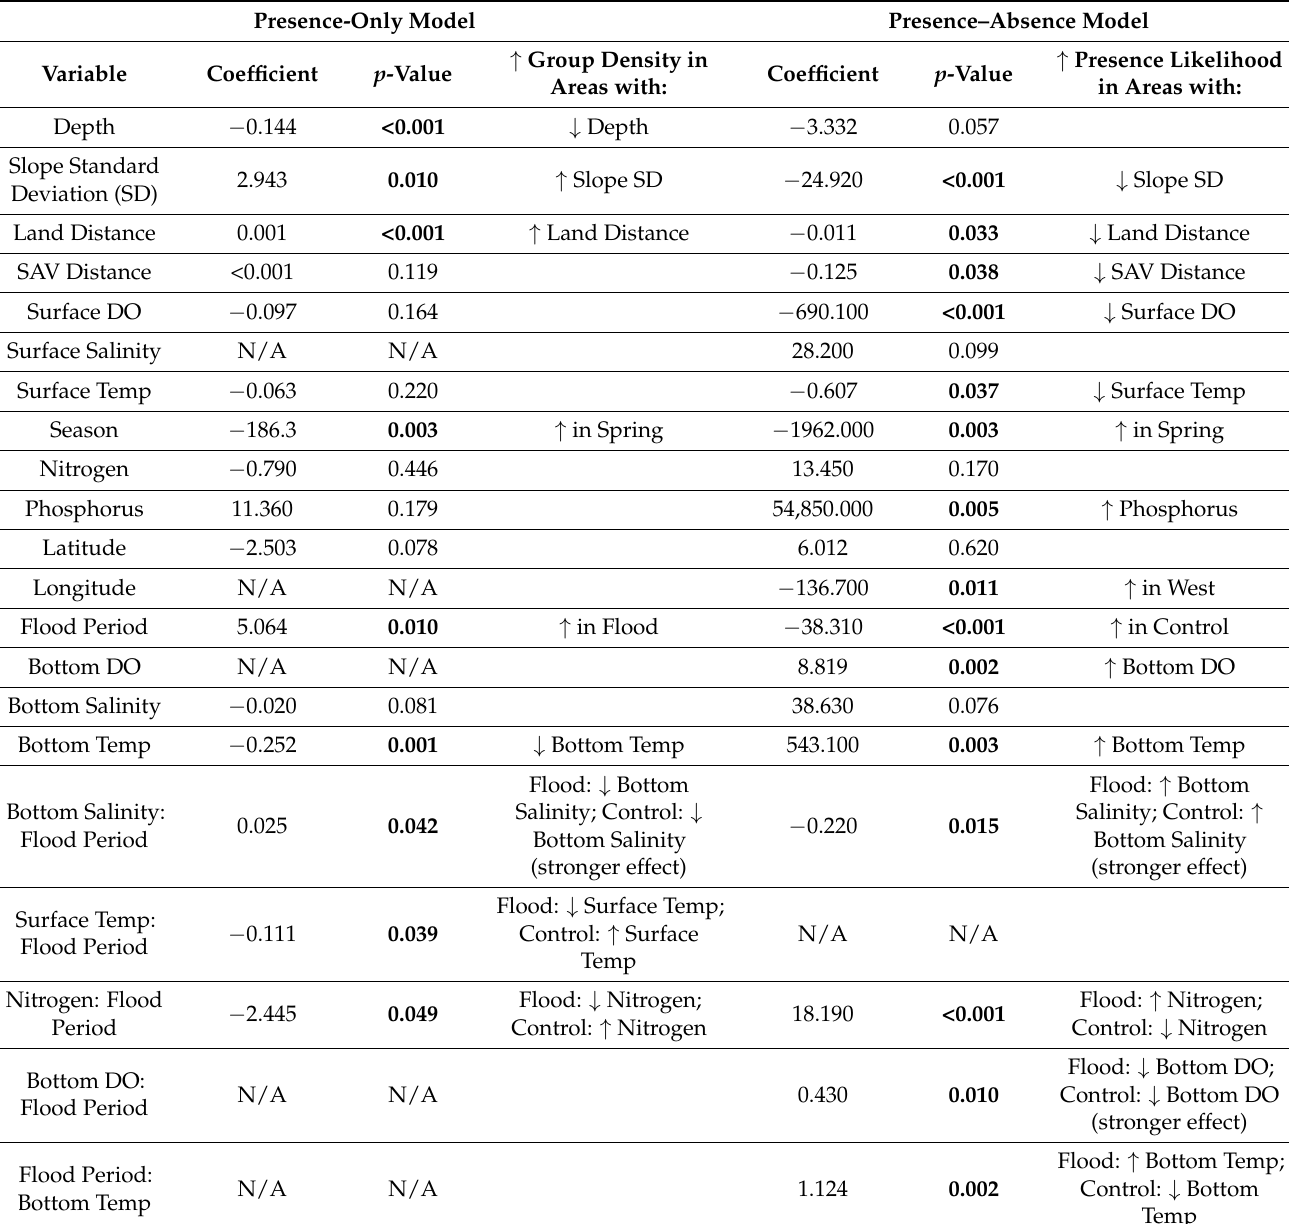
Table 3. Flood-related model parameters for ZAG model (significant associations in bold). Presence-Only Model Presence–Absence